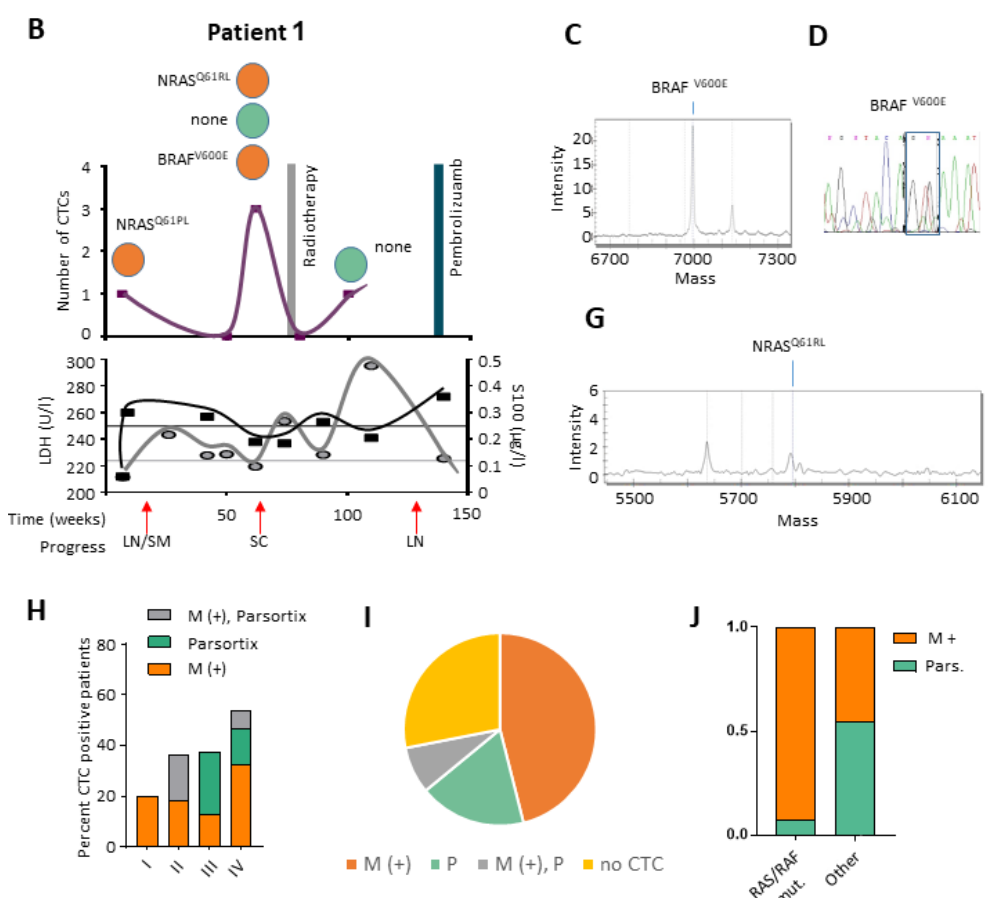
Figure 3. Combined enrichment method for the analysis of cellular subpopulations of circulating melanoma cells in patients. ( A ) Overview of patients with cutaneous, acral, mucosal and uveal melanoma of different disease stages, included in the study. ( B ) Time course of CTCs, enriched by positive selection (orange circles) and Parsortix TM (green circles) and their detected mutations, as well as LDH and S100 serum levels in patient #1. ( C ) Mass spectrum plot of BRAFV600E mutation and ( D ) Sanger sequencing of the same sample. ( G ) Mass spectrum plot of NRASQ61RL mutation. ( H ) Percentage of patients positive for circulating melanoma cells enriched by positive selection (MACS, M+), Parsortix TM or both. ( I ) Distribution of enriched CTCs in stage 4 patients prior to treatment. ( J ) CTCs enriched by positive selection, and Parsortix TM in NRAS/BRAF mutated patients, and not BRAF/NRAS mutated patients.